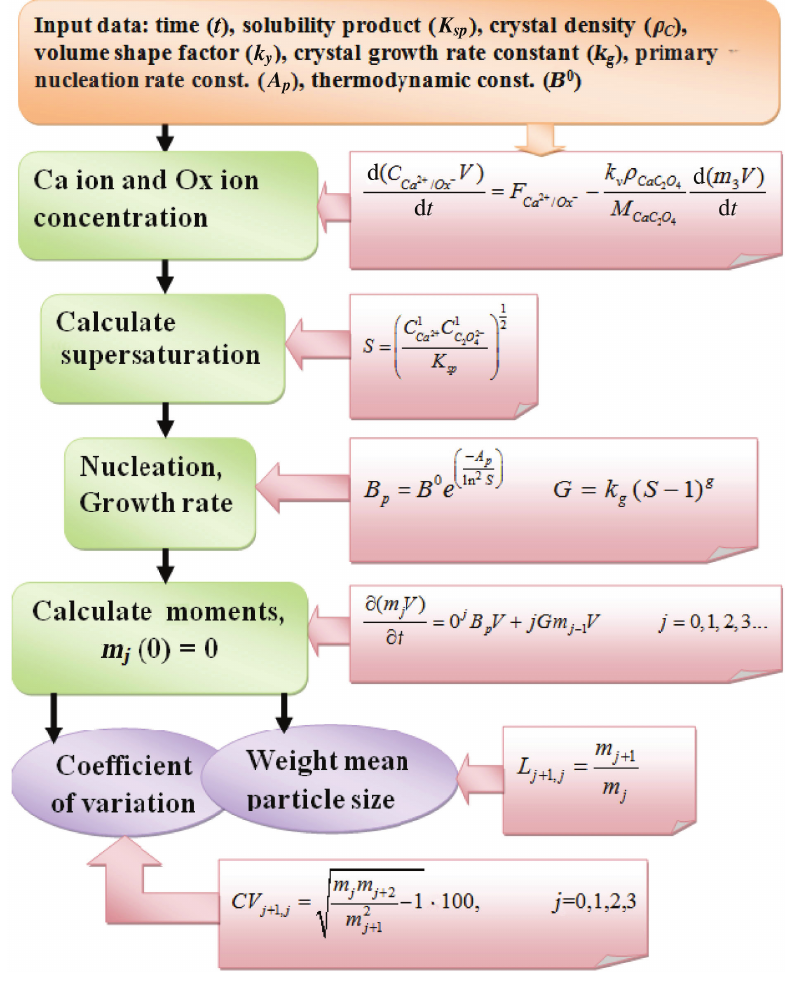
Fig. 1 – Schematic view of studied process